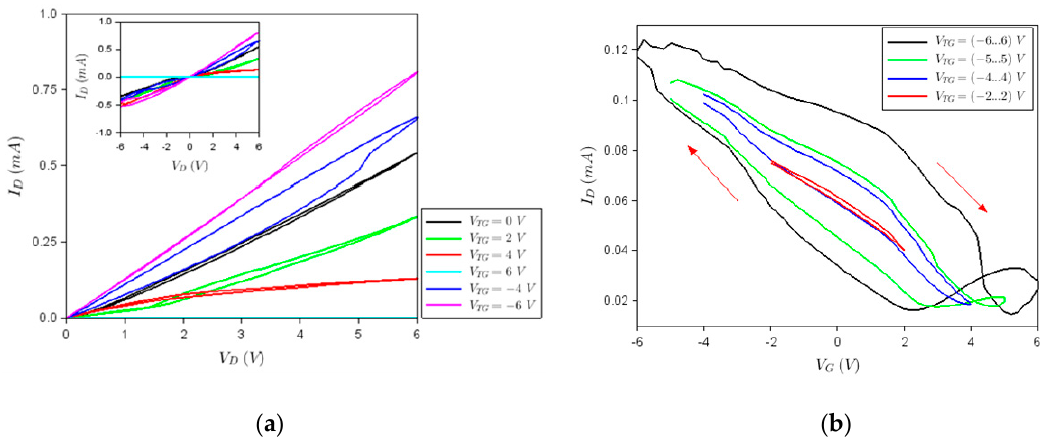
Figure 3. ( a ) Drain current versus positive drain voltages at various top gate voltages indicated in the legend when V BG = 0. Inset: full I D − V D dependence for both drain voltage polarities. ( b ) Drain current versus top gate voltage hysteretic dependence at a di ff erent V TG sweep, when V BG = 0.